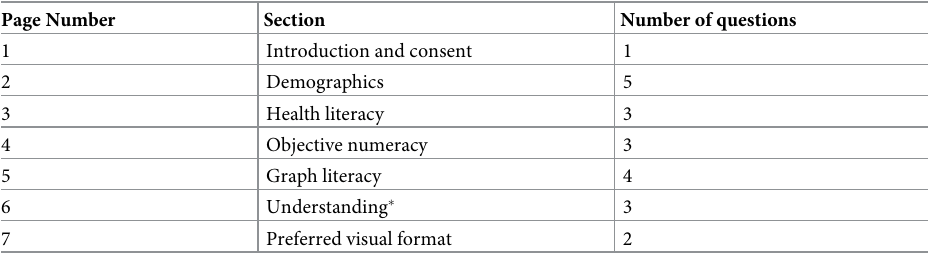
Table 1. Overview of survey